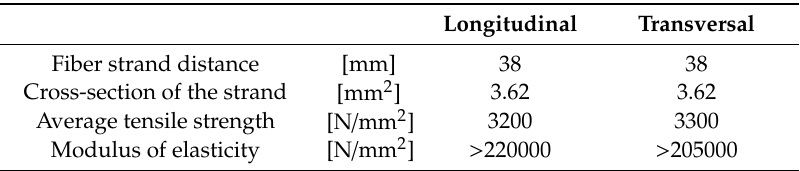
Table A1. Characteristics of the textile (values according to [18]).